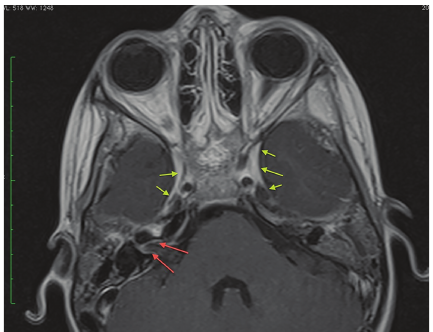
Figure 3: Axial post-Gad T1WI FSE. Dural enhancement is noted along the cavernous sinuses (yellow arrows). There is dural enhancement extending into the right internal auditory canal, with abnormal enhancement of the facial and vestibulocochlear nerves (red